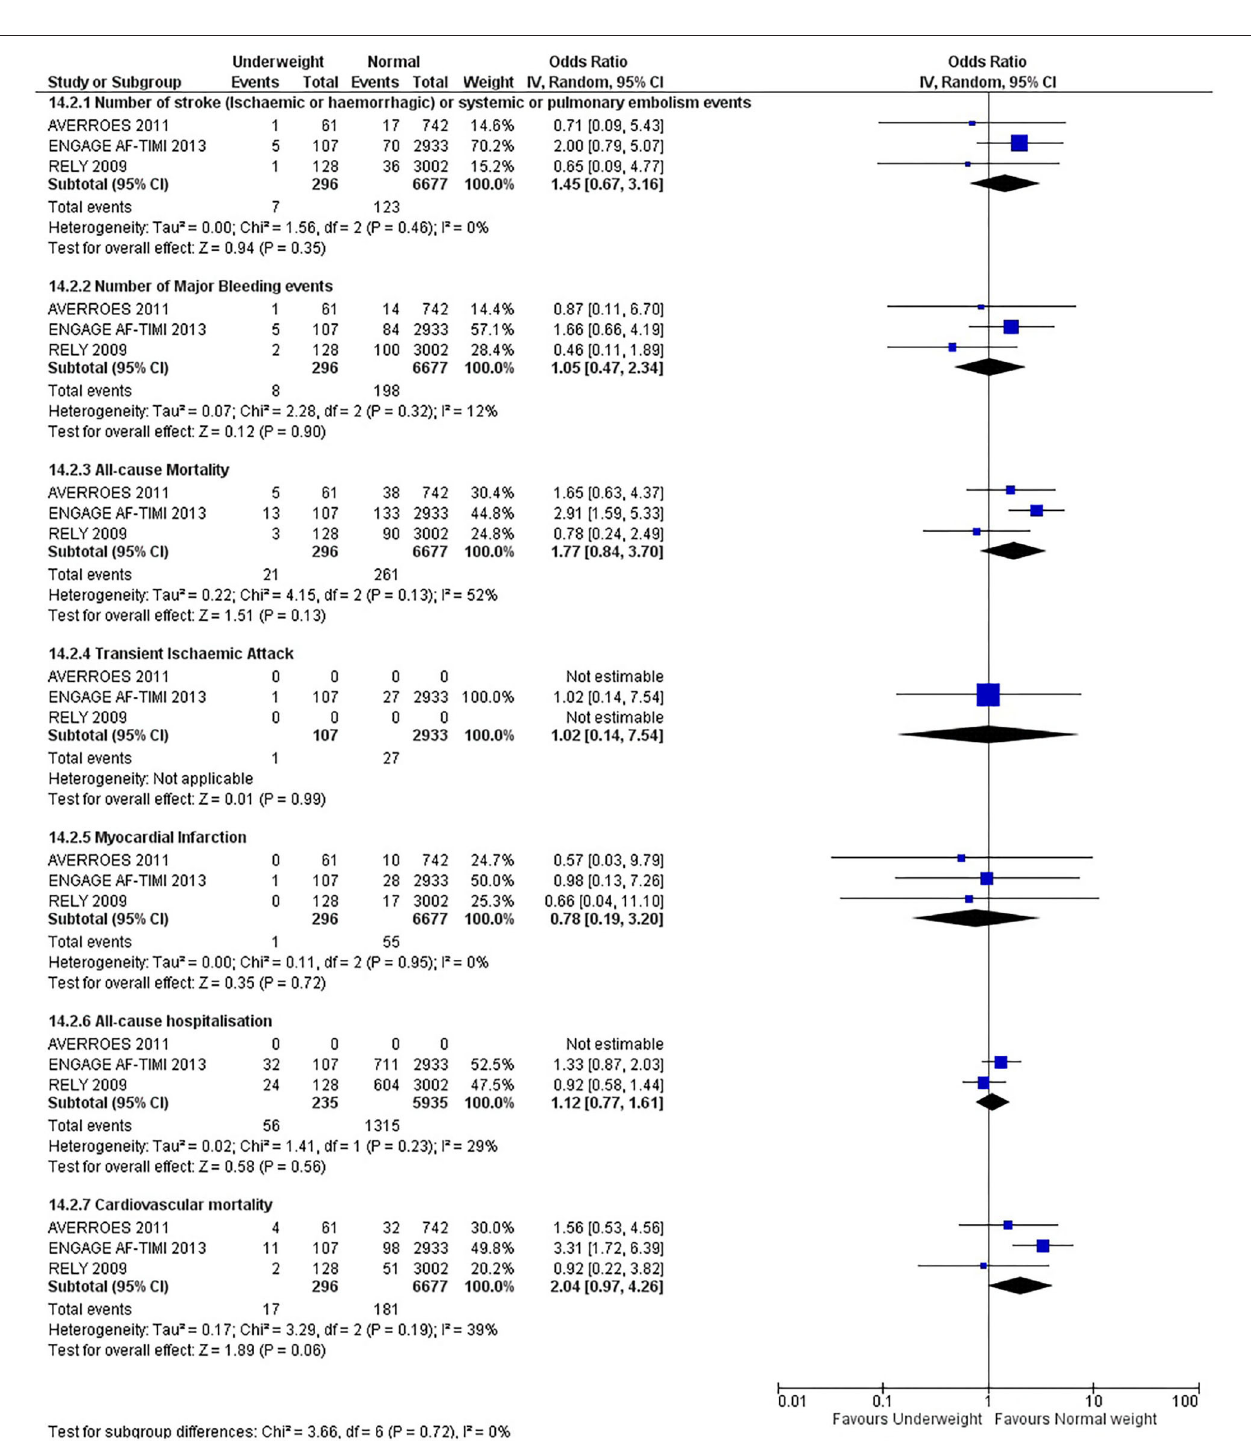
FIGURE 3 | Forest plot of comparison: Normal vs. Underweight at 12